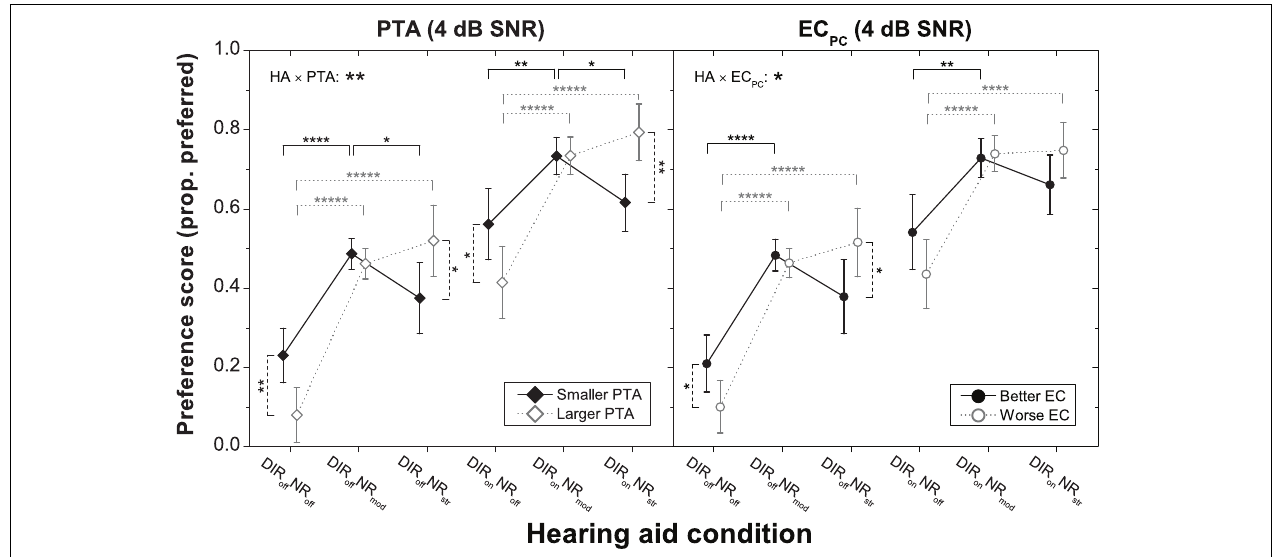
FIGURE 5 | Mean preference scores for the six HA conditions at 4dB SNR for the “smaller PTA” and “larger PTA” subgroups (left panel) and the “better EC” and “worse EC” subgroups (right panel). Error bars show 95% confidence intervals. Black solid horizontal bars denote significant differences for the “smaller PTA” and “better EC” subgroups,